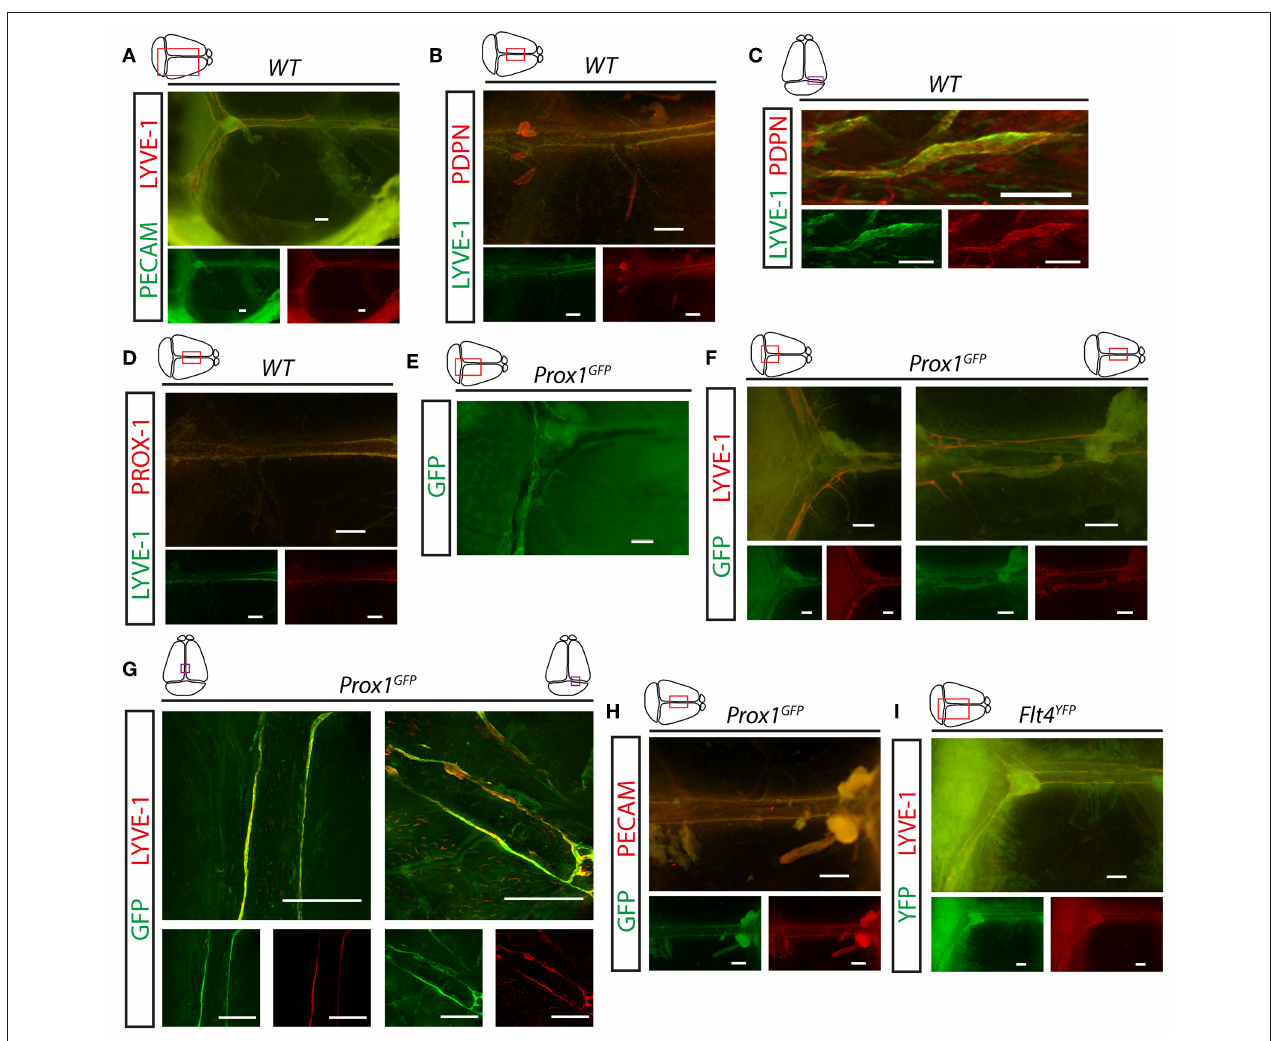
FIGURE 1 | Expression of lymphatic markers in meninges of young adult mice. (A) Expression pattern of PECAM and LYVE-1 shown in the dura mater of young adult wild type mice ( n = 7). Bars, 500 µ m. (B,C) LYVE-1 and PDPN immunostaining of mouse meninges imaged by fluorescent stereo microscopy ( n = 12; bars, 500 µ m) (B) or confocal imaging ( n = 3; bars, 100 µ m) (C) . (D) LYVE-1 and PROX-1 immunostaining of meninges ( n = 4). Bars, 500 µ m. (E–G) Expression pattern of GFP, LYVE-1 and PECAM adjacent to the venous sinuses of the meninges of Prox1 GFP lymphatic reporter mice at P21. Images are shown for native GFP signal ( n = 5; bars, 500 µ m) (E) , GFP and LYVE-1 immunostaining detected by fluorescent stereo microscopy ( n = 6; bars, 500 µ m) (F) or confocal microscopy ( n = 3; bars, 200 µ m) (G) . (H) Expression pattern of GFP and PECAM shown by fluorescent stereo microscopy after whole-mount immunostaining of wild type meninges ( n = 5). Bars, 500 µ m. (I) Expression of YFP and LYVE-1 adjacent to the venous sinuses of the meninges of young adult Flt4 YFP lymphatic reporter mice shown by GFP and LYVE-1 immunostaining ( n = 3). Bars, 500 µ m. Representative images are shown in all